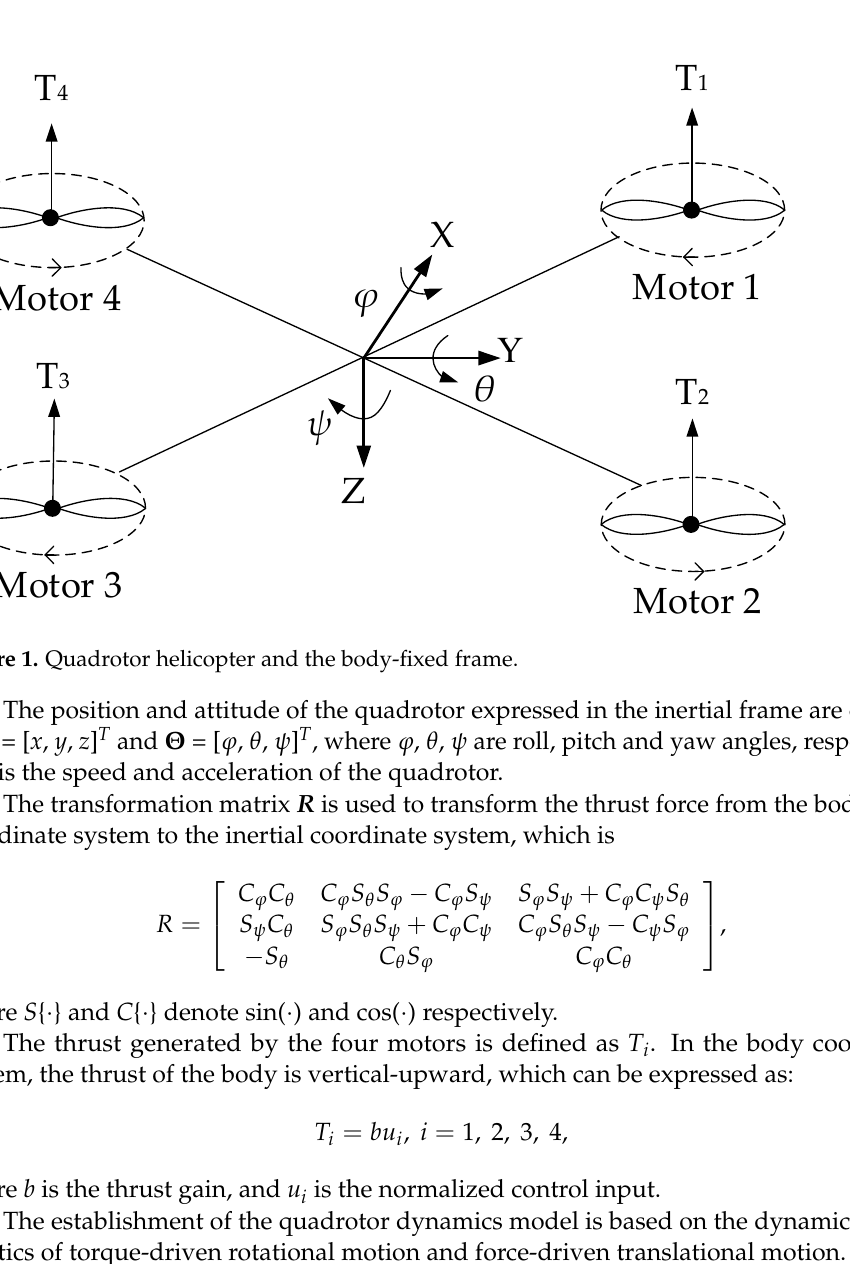
where b is the thrust gain, and u i is the normalized control input. The establishment of the quadrotor dynamics model is based on the dynamic charac- teristics of torque-driven rotational motion and force-driven translational motion. For the rotational motions, with the Euler’s equation of a rigid body, the sum of torque applied to the quadrotor can be expressed as